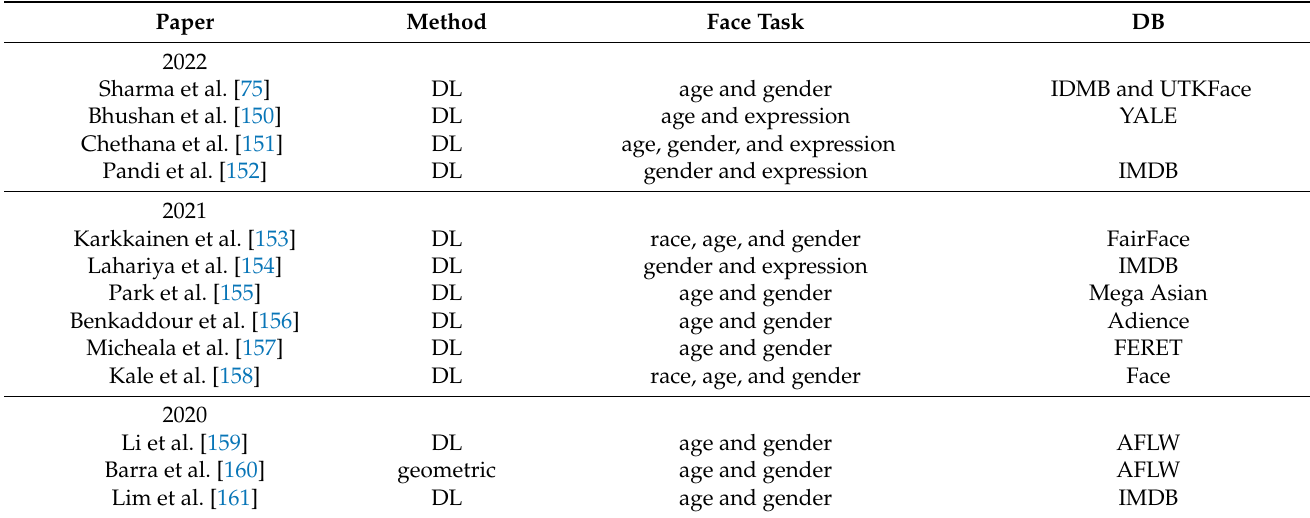
Table 3. Face image analysis yearly progress